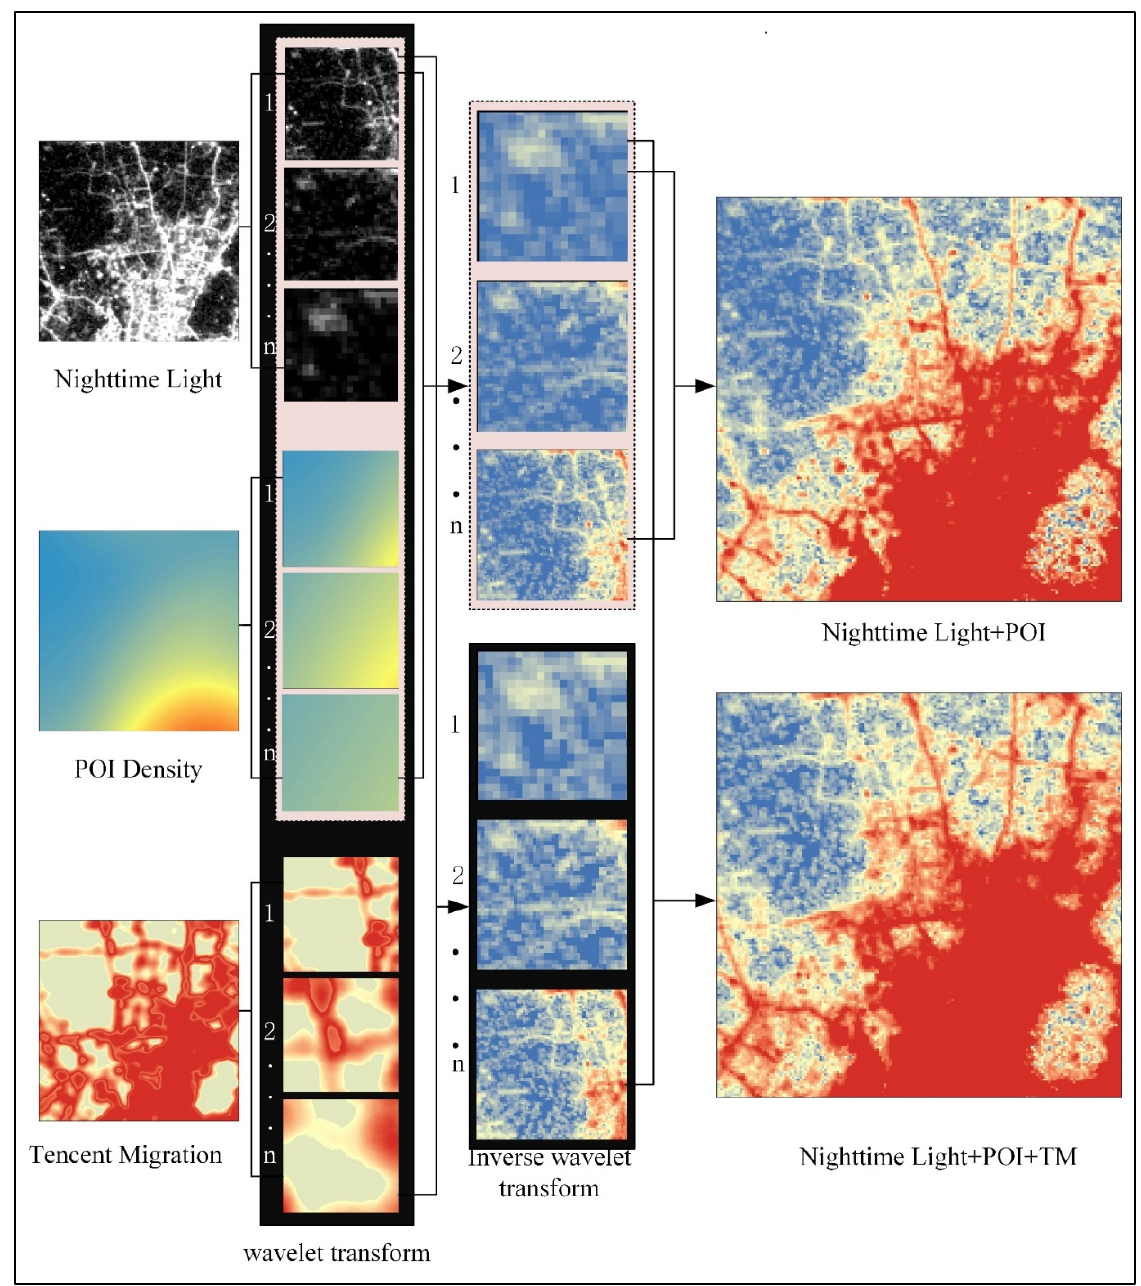
Figure 5. The fusion process of multi ‐ source big data.